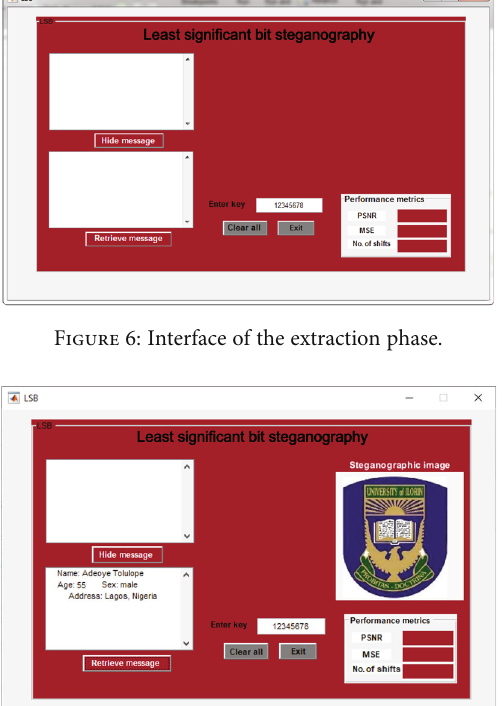
Table 2: Comparison with other LSB steganography technique.